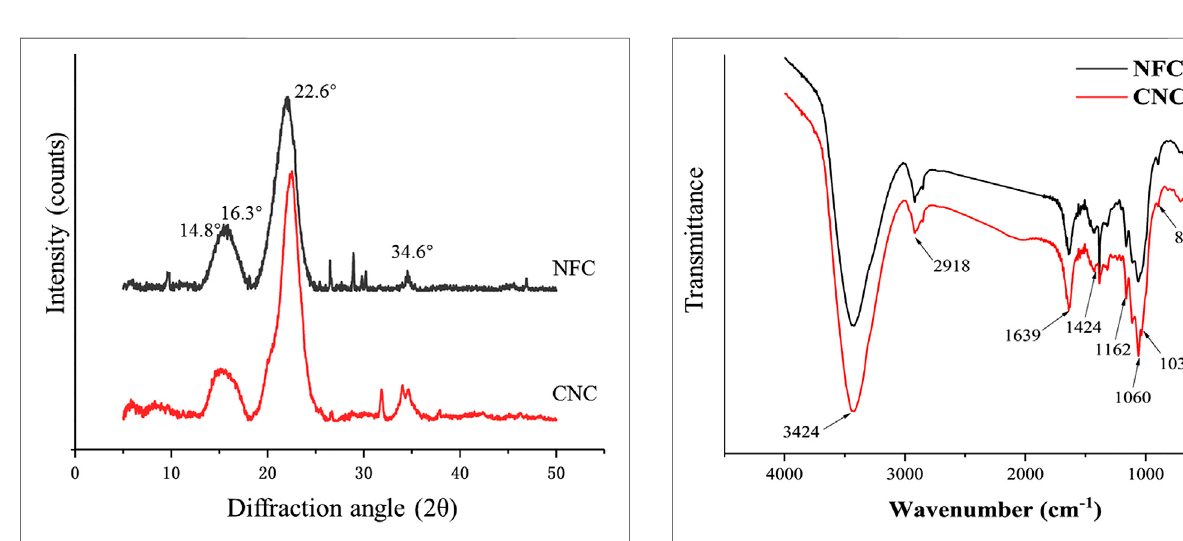
FIGURE 3 | X-ray diffraction pattern of bamboo shoot NFC and CNC. FIGURE 4 | FTIR spectra of bamboo shoot NFC and